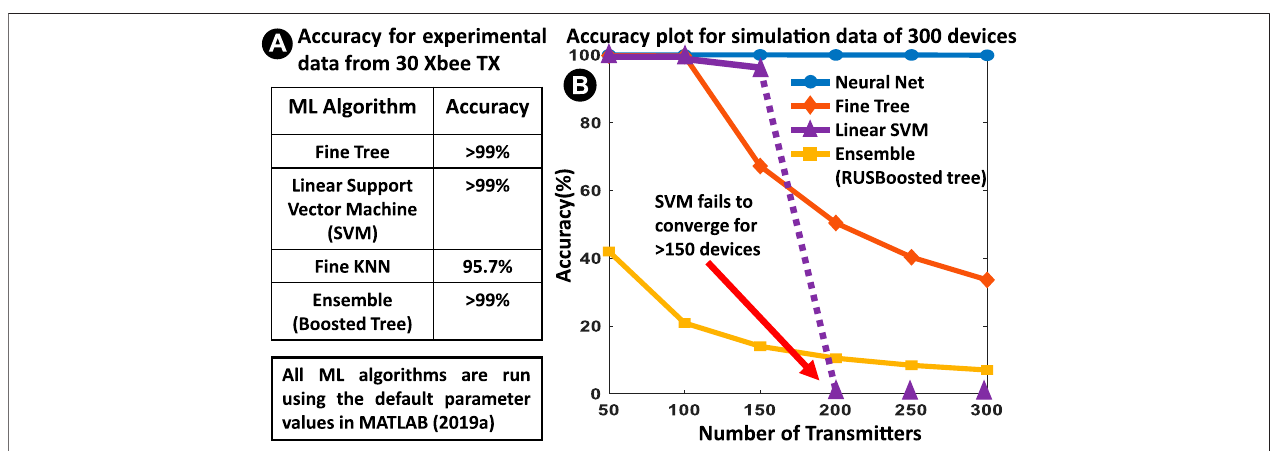
FIGURE 6 | (A) Popular ML algorithms show high accuracy for 30 Xbee devices. (B) The accuracy of simple ML networks drops when the number of TX is large, wherein the neural network still holds up with > 99 . 9 % accuracy.